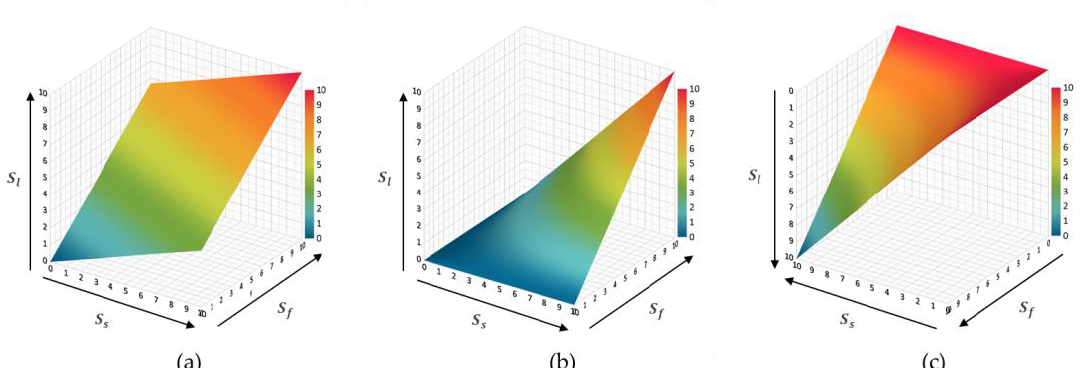
Figure 12. Vessel traffic index expression methods: ( a ) average operation, ( b ) product operation, and ( c ) product of reciprocal operation.